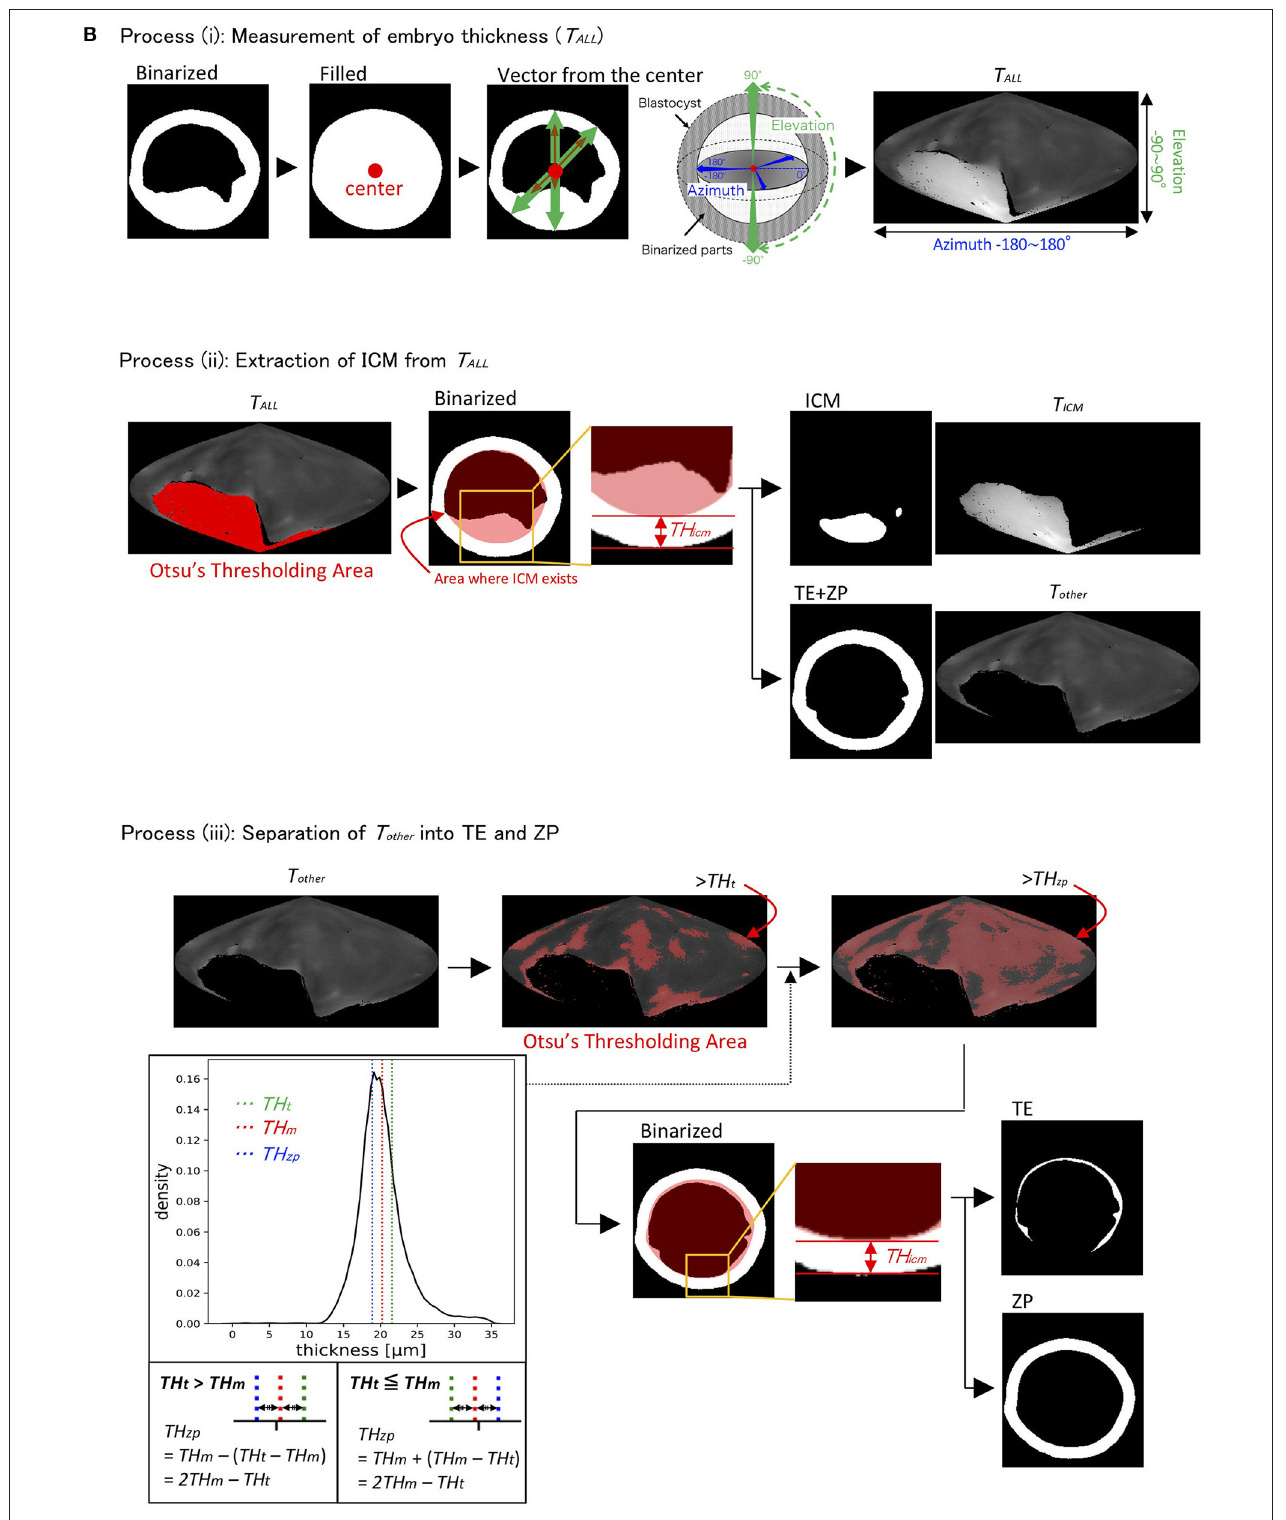
FIGURE 3 | The binarized image was separated into the inner cell mass (ICM), trophectoderm (TE), and zona pellucida (ZP) through processes (i)–(iii) (A) . (B) Process (i): Thickness of embryo ( T ALL ) was measured by drawing vectors from the center to the outer and inner surfaces (the outermost of blastocoel) of the